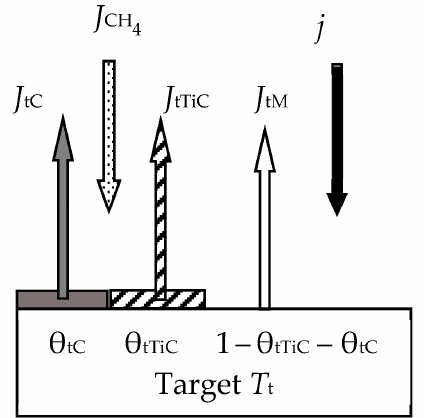
Figure 12. The fl uxes on the target surface. Figure 12. The fluxes on the target surface.